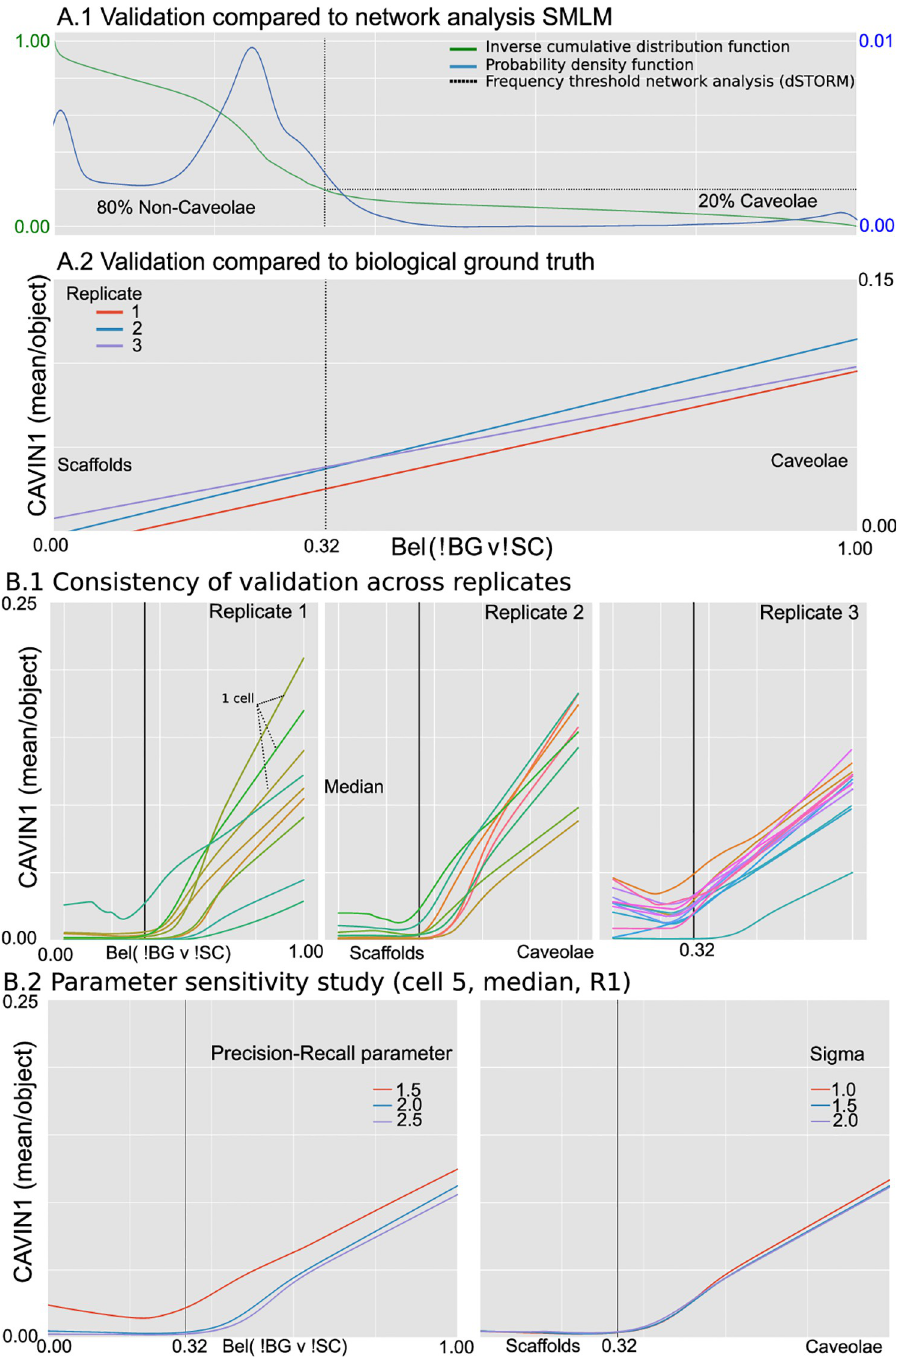
Fig 9. Results on CAV1 dataset. A: Validation with respect to previous art (A.1) and biological ground truth (A.2). A: The distribution of SPECHT’s label (A.1, x-axis: P[object] = caveolae) shows a distinct long left tail, containing 20% of the data. The frequency division matches previous art in dSTORM analysis. Caveolae only form in the presence of CAVIN1, therefore the probability of an object being Caveolae should correlate with the colocalization of CAVIN1 (A.2), which is what we observe. B.1: The detection threshold ( * 0.35, A.1–2) matches the sudden rise in colocalization when we use a LOWESS regression, rather than a linear regression, and results are consistent across 3 replications (30 cells total, each line represents a single cell). B.2: Varying hyperparameters does not alter the consistency of the result with respect to biological ground truth (colocalization CAVIN1). The dotted line corresponds to the frequency (20%) of Caveolae detected in dSTORM using network